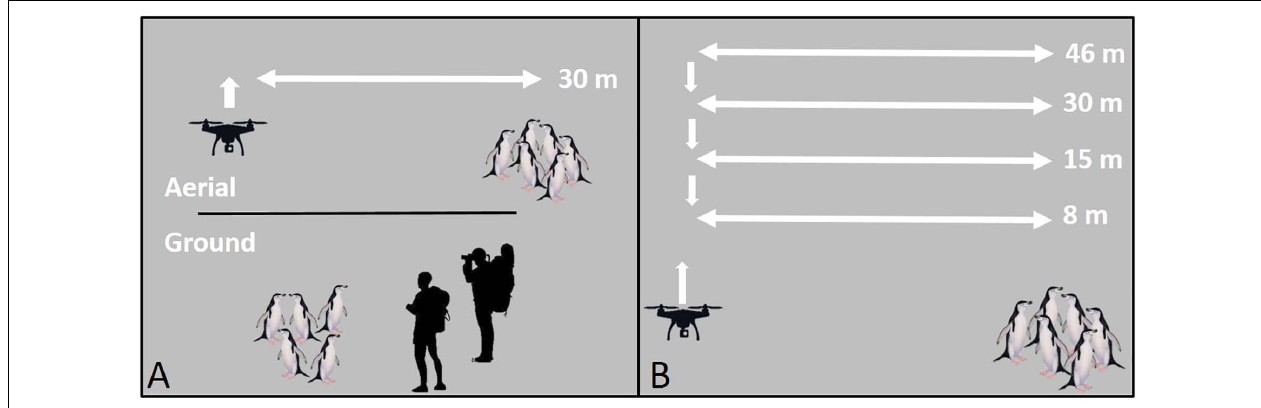
FIGURE 1 | A schematic of unoccupied aerial systems (UAS) flight patterns for the (A) survey comparison study, and (B) altitude comparison study using penguins as an example species. All take-offs, landings, and mid-flight altitude changes were conducted ≥ 50 m from target animals.